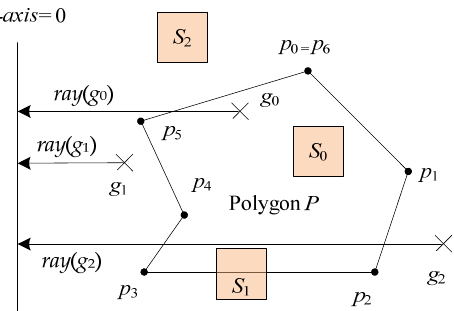
Figure 2. Example of a polygon with point and space statuses.